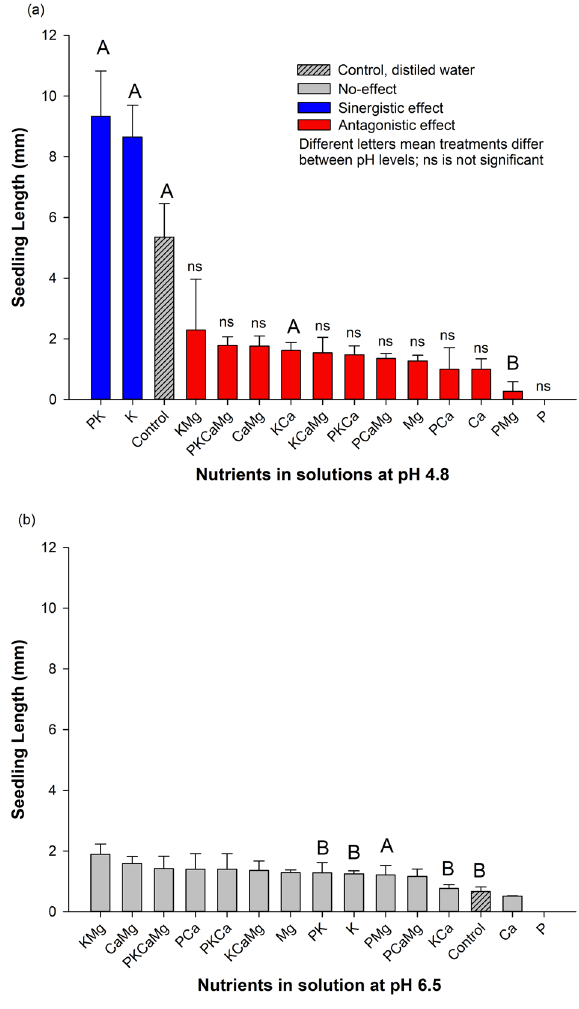
Figure 3. Seedling length in aerial part (SL) of Conyza canadensis in response to the nutrients (alone or in combination) under solutions at pH 4.8 ( a ) and at pH 6.5 ( b ). Bars with the different colours, comparing means among treatments, are significantly different, according to the Tukey’ test ( p < 0.05). Different letters represent a statistical difference for the same treatment between the two pH tested while ns represents not significant; The results in the Bars represent means, while error bar marks represent standard deviation ( n = 4) from the mean